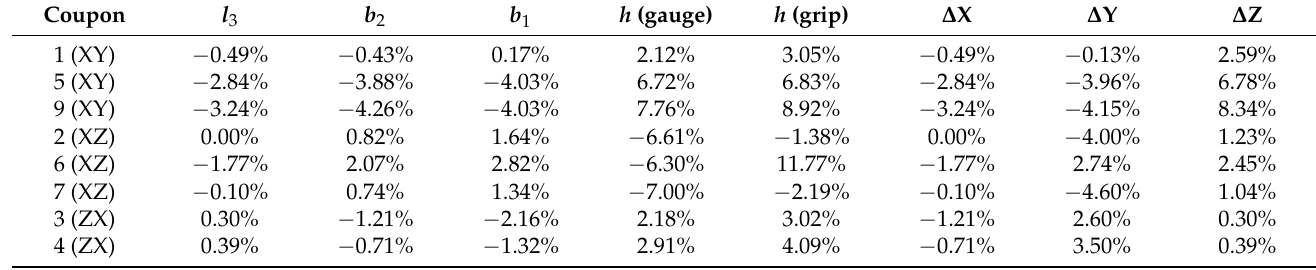
Table 6. Dimensional variations of coupons after thermal annealing.